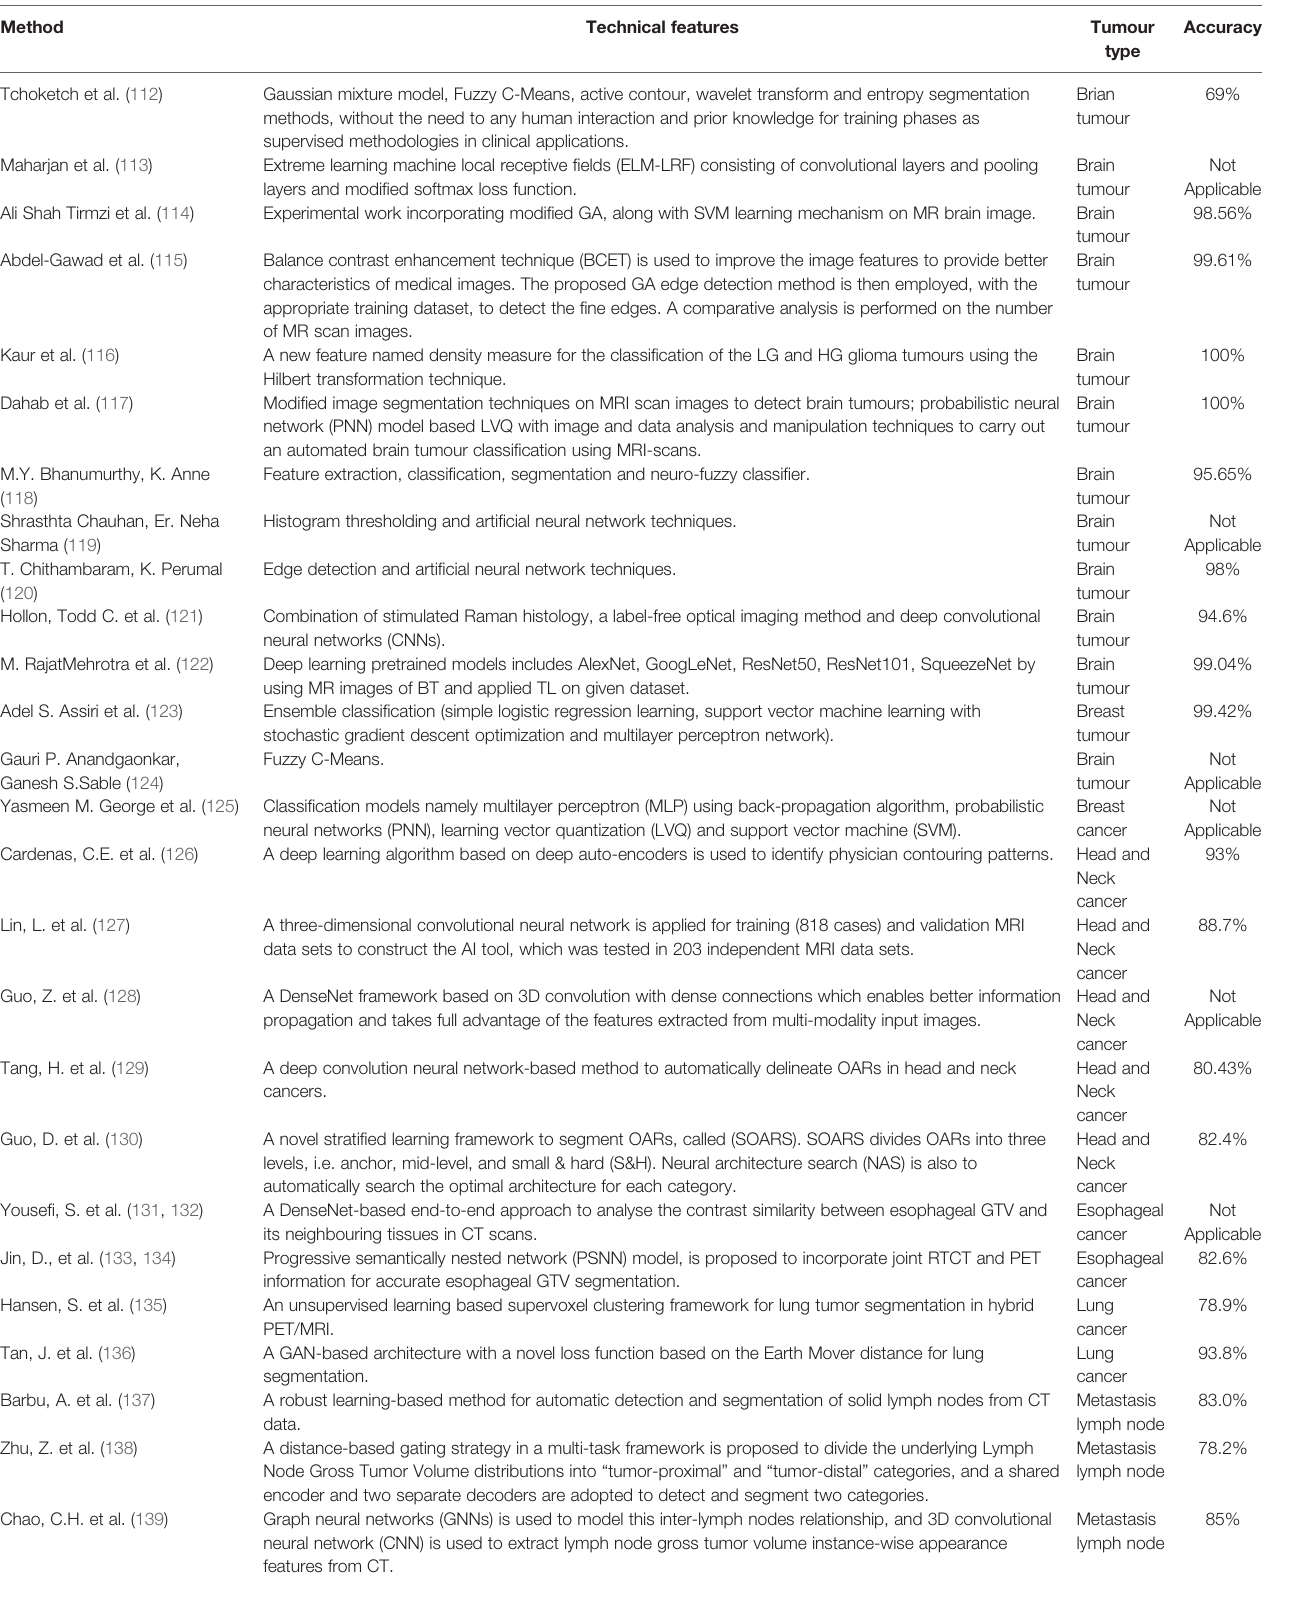
TABLE 3 | Recent AI-based tumour segmentation